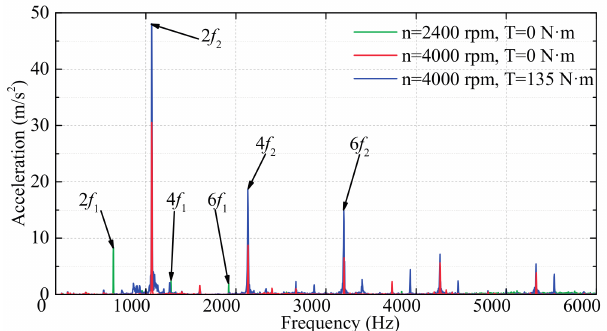
Figure 17. The vibrating spectral analysis of the investigated IPMSM prototype at different operations. ( f 1 and f 2 are the fundamental frequencies of the rotating magnetic field at rated speed and peak speed,